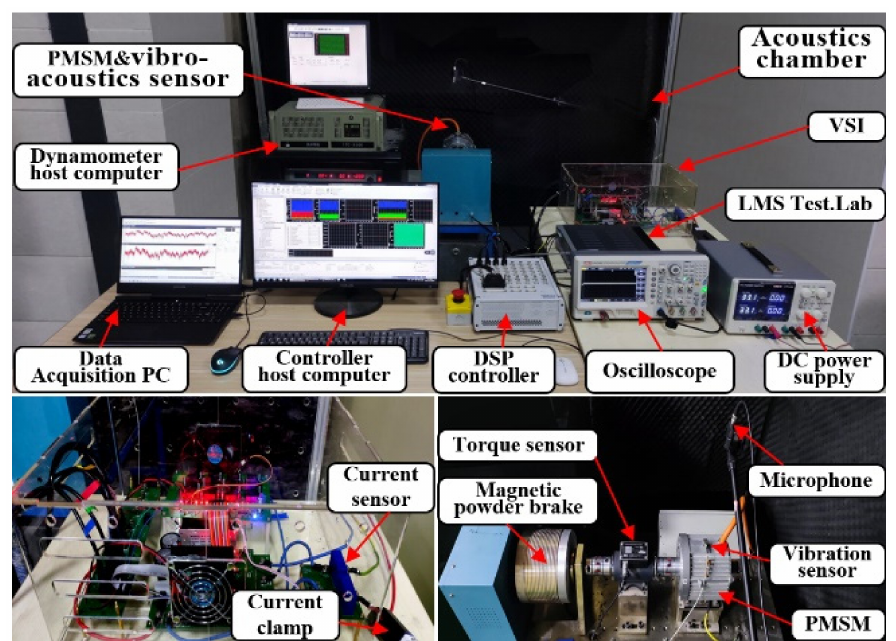
Figure 6. Experimental setup with the PMSM and